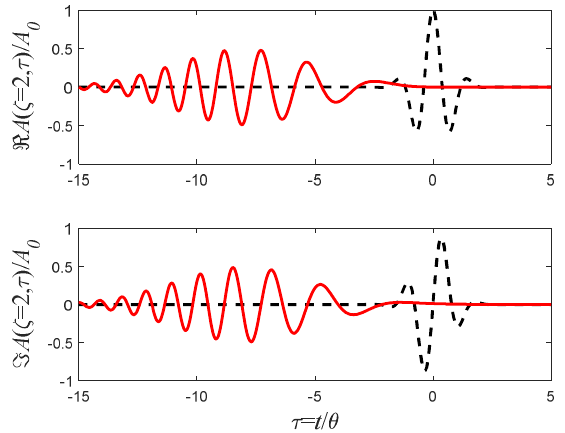
Figure 3. The real (upper panel) and imaginary (lower panel) components of the Gaussian pulse (Equation (16)). The dashed curve represents the initial profile (for ζ = β 2 z / θ 2 = 0), while the solid curve represents its final shape (for ζ = β 2 z / θ 2 = 2). In this example, the carrier frequency is ω 0 = − 4/ θ .